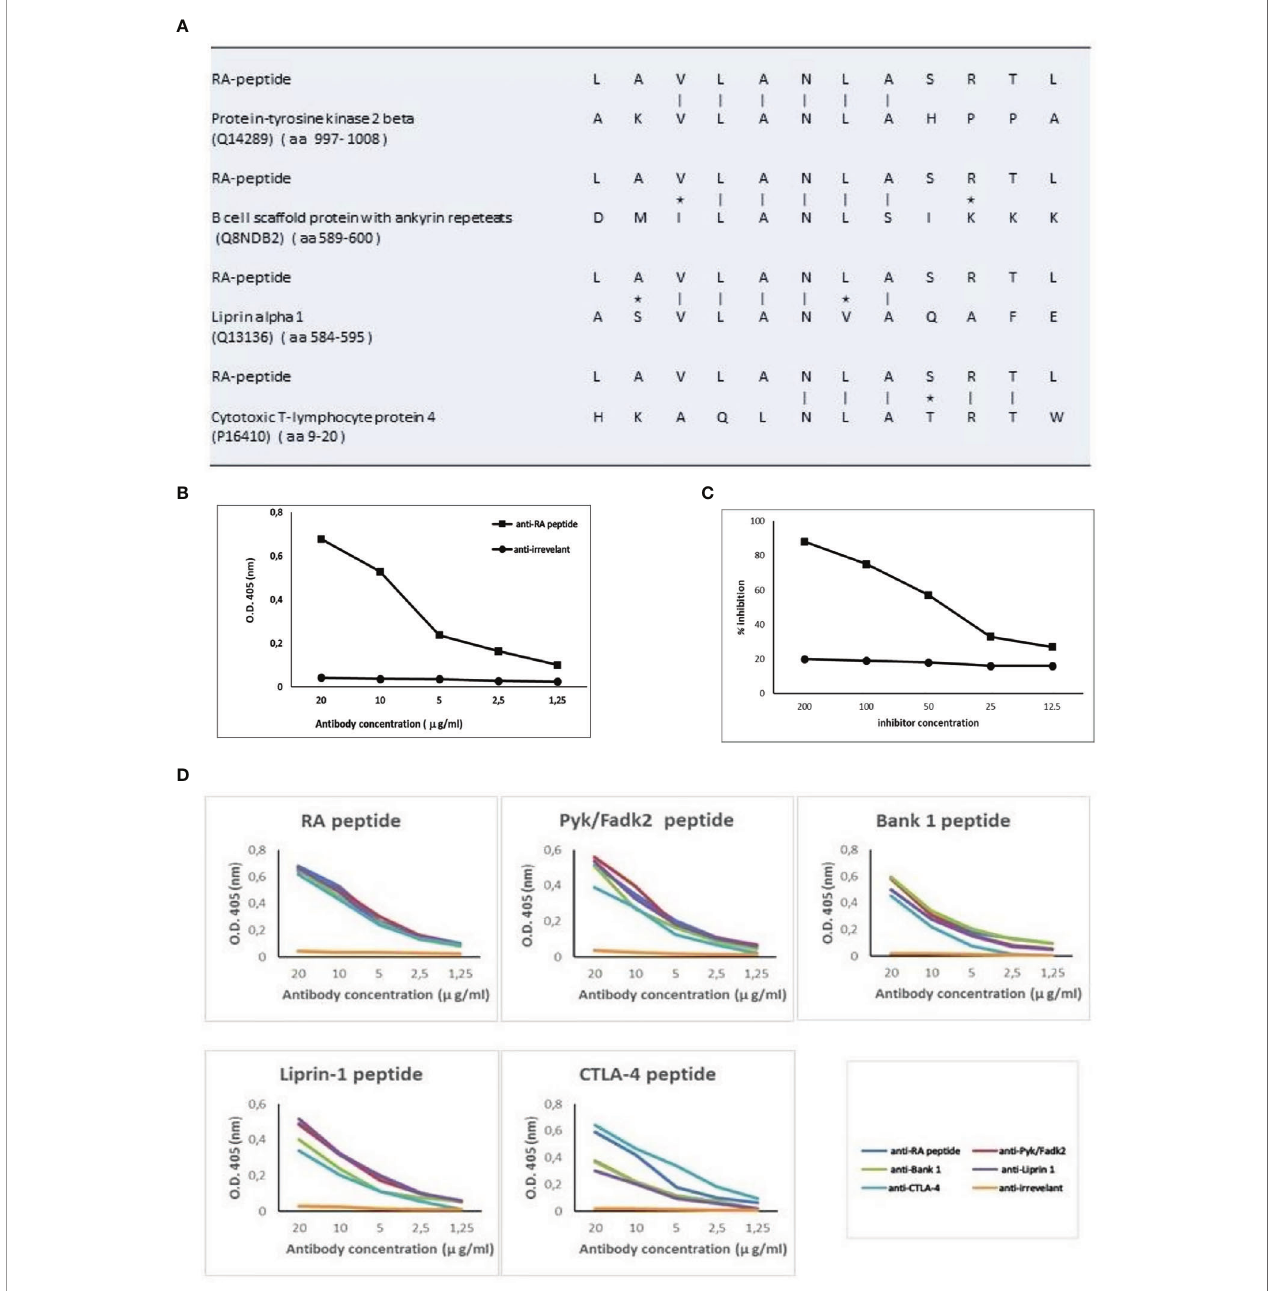
FIGURE 3 | RA-peptide shares sequence homology with human self-proteins and anti-RA-peptide antibodies are cross-reactive. (A) Sequence homology between RA-peptide and autoantigens, analyzed by the basic local alignment search tool using the National Center for Biotechnology Information (NCBI) network service. Vertical line = identical amino acids; asterisk= conservative substitutions. (B) Direct binding of af fi nity puri fi ed anti-RA-peptide antibodies or anti-irrelevant peptide antibodies to RA synthetic peptide evaluated by ELISA assay. Data are plotted in a graph displaying absorbance (O.D.) at 405 nm on the vertical axis and antibody concentration expressed in m g/ml on horizontal axis. (C) Inhibition ELISA test: the binding of af fi nity-puri fi ed antibodies to RA-peptide was inhibited by RA synthetic peptide ( ■ ), but not by an irrelevant peptide ( ● ). On vertical axis the inhibition percentage is reported, while on horizontal axis the inhibitor concentration ( m g/ml) is shown. (D) Speci fi c binding of cross-reactive IgG antibodies to peptides: af fi nity-puri fi ed antibodies against RA (blue line), Pyk/Fadk2 (red line), Bank-1 (green line), Liprin-1 (purple line), CTLA-4 (light blue line) and irrelevant (orange line) peptides were used in a direct binding assay with each one of the 5 synthetic peptides. Graph displays absorbance (O.D.) at 405 nm on vertical axis and antibody concentration m g/ml on horizontal